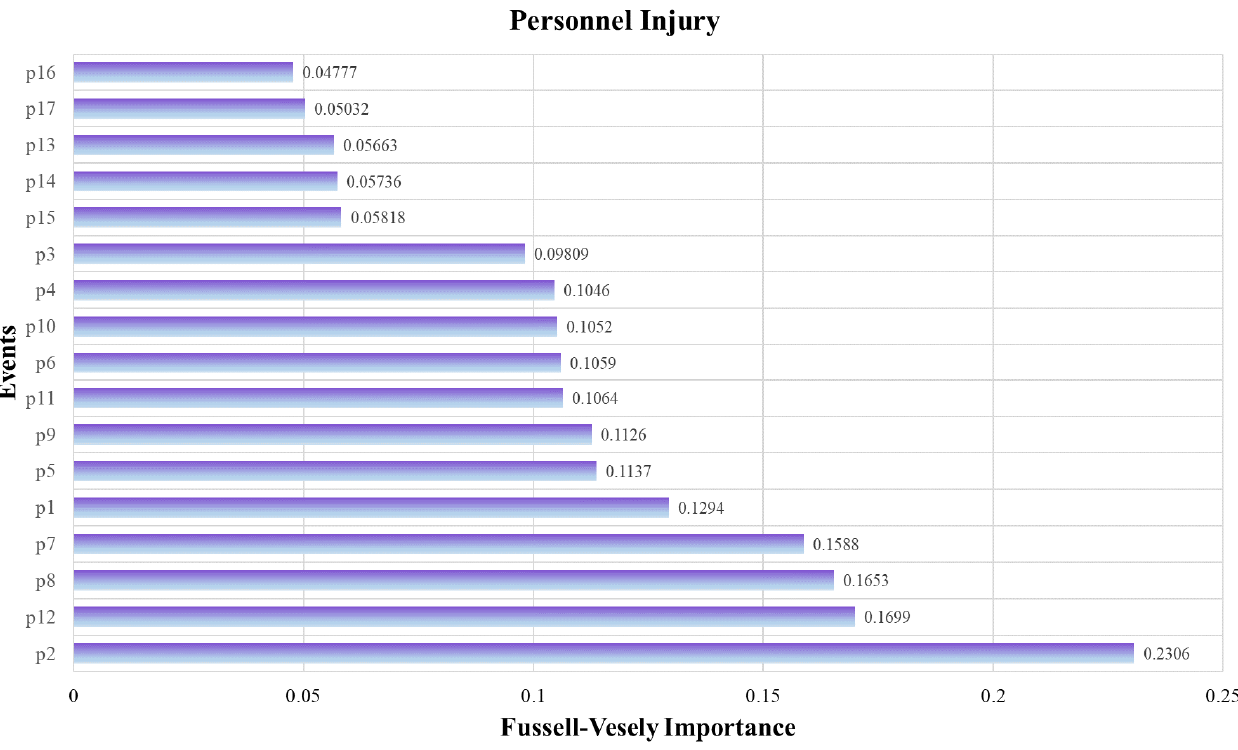
Figure 13. Fussell–Vesely Importance of each basic event of personnel injury accident.